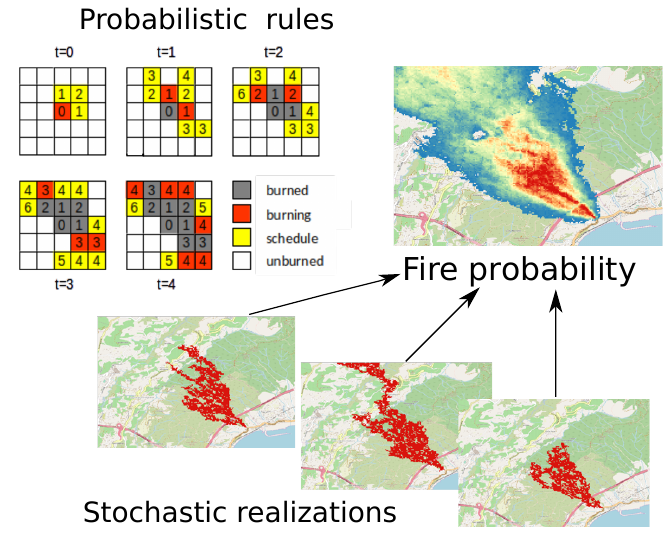
Figure 4. Averaging procedure of single realization adopted in PROPAGATOR .